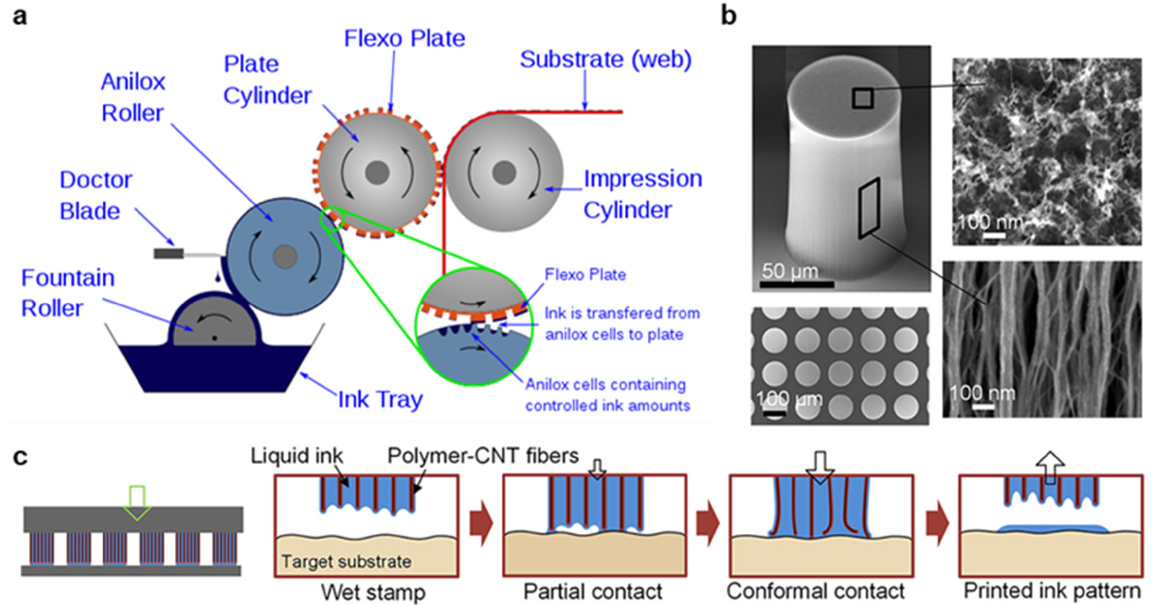
Figure 3. Advanced flexographic printing techniques. ( a ) Diagram of a standard flexographic printer to illustrate the key operating principles. (reproduced under creative commons license CC BY-SA 4.0). ( b ) Scanning electron microscope images of a CNT array (100 µm pillar diameter, 150 µm height) used for high-resolution flexography, and close-up top and side surfaces of a micropillar (reproduced with permission from Langmuir (2019), 35, 24, 7659–7671. Copyright 2019, ACS). ( c ) Simplified schematic of ink transfer from carbon nanotubes (CNTs) micropillar stamp loaded with ink. (reproduced with permission from Langmuir (2019), 35, 24, 7659–7671. Copyright 2019, ACS).